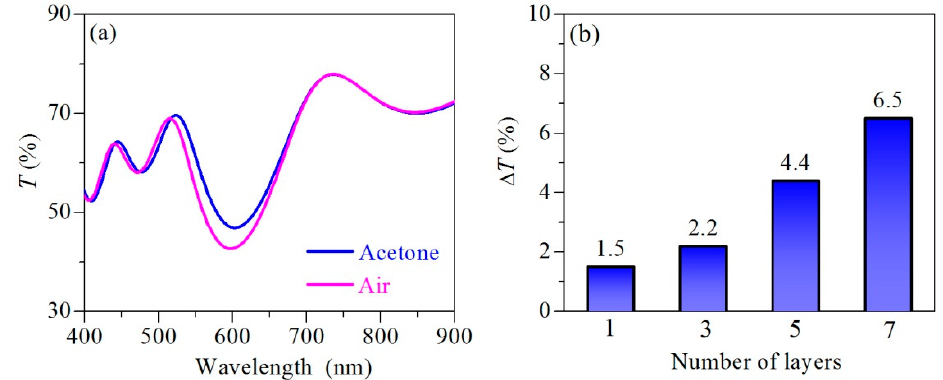
Figure 9. ( a ) Calculated transmittance spectra T in air and acetone vapors of a computer-modeled seven-layer Bragg stack consisting of undoped Nb 2 O 5 matrix and matrix doped with 5% Na-X 120 zeolites; ( b ) calculated change in transmittance ∆ T = | T ac − T argon | due to acetone vapors exposure as a function of the number of the layers in the stack.